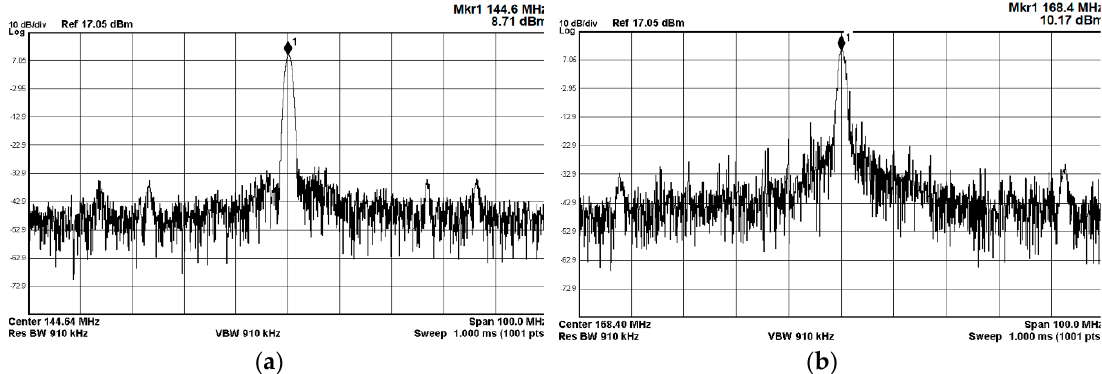
Figure 7. Frequency spectrum measurement results of the proposed LC DCO divide-by-64 output ( a ) when operating at the lowest operating frequency, and ( b ) when operating at highest operating frequency. Measurements were performed using Keysight Technologies N9010A EXA signal analyzer.